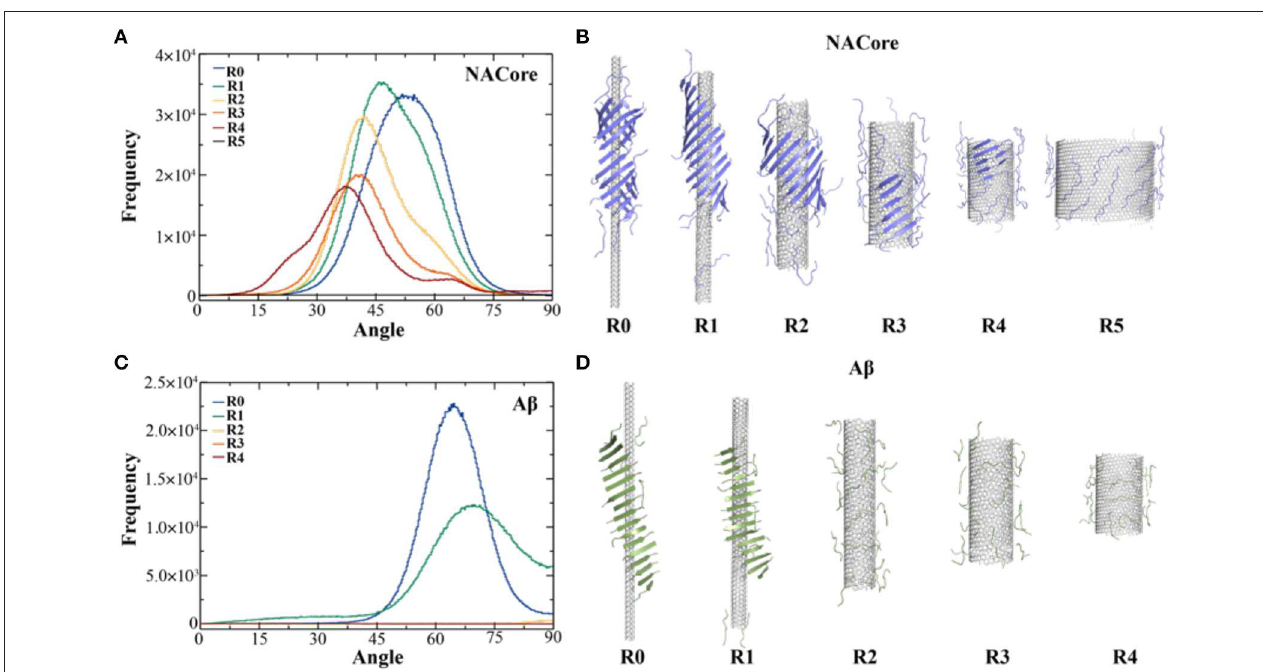
FIGURE 2 | Self-assembly of amyloid peptides in the presence of CNT of different radii. (A) The distribution of angles between CNT axis and β -strands for the assembly of 20 NACore with CNT of different radii, ranging from R0 ∼ 2.0 Å, R1 ∼ 3.8 Å, R2 ∼ 7.6 Å, R3 ∼ 10.7 Å, R4 ∼ 14.2 Å, to R5 ∼ 28.2 Å. (B) The corresponding typical snapshots for CNT of different radii were shown. Similar results for A β were shown in panels (C,D) .